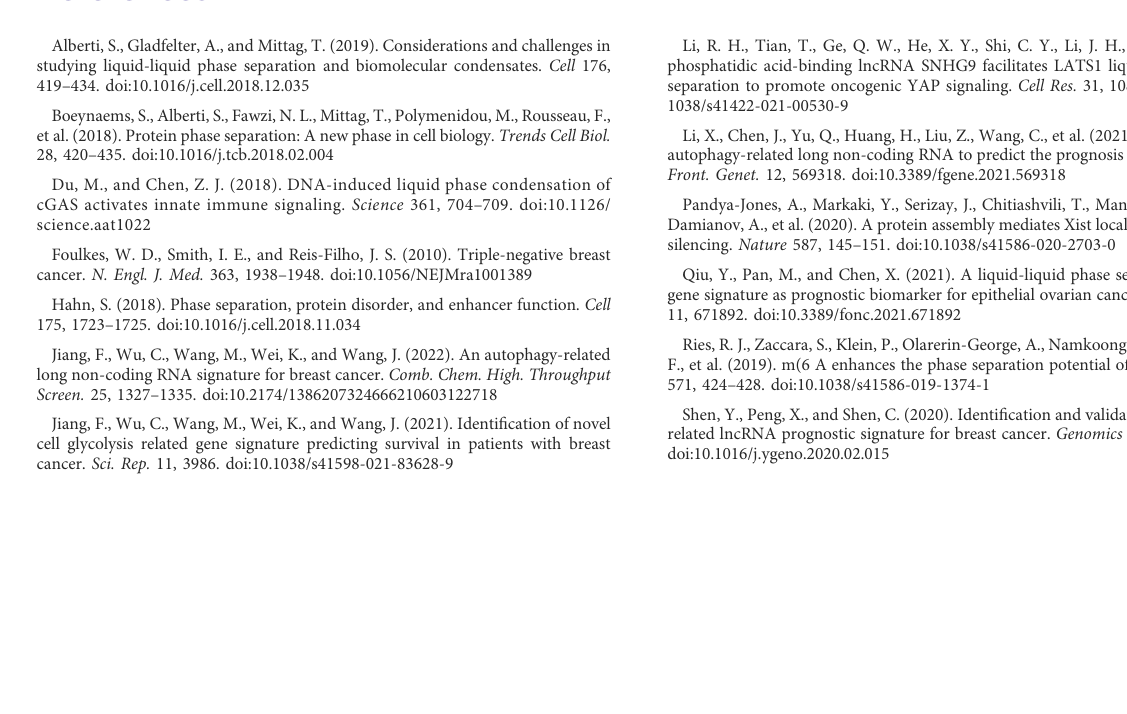
SUPPLEMENTARY FIGURE S1 LASSO analysis to narrow the candidate genes. Binomial deviance and coef fi cientsinallcohorts (A,D) ,intheluminalcohort (B,E) ,andtheTNBC cohort (C,F) . SUPPLEMENTARY FIGURE S2 Externalveri fi cationofLCG-basedrisk-scoreandage. (A) ROCvalueof1/ 3/5/7-year overall survival in LCG-based risk-score. (B) ROC value of 1/ 3/5/7-year metastasis-free survival in LCG-based risk-score. (C) ROC valueof1/3/5/7-yearoverallsurvivalinLCG-basedrisk-scoreandage. (D) ROC value of 1/3/5/7-year metastasis-free survival in LCG-based risk- score and